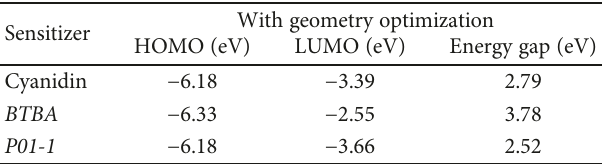
Figure 1: Fundamental molecular structure of cyanidin, BTBA , and P01-1. Table 1: Summary of DFT computational calculation of cyanidin, BTBA , and P01-1 constituents in ethanol with geometry